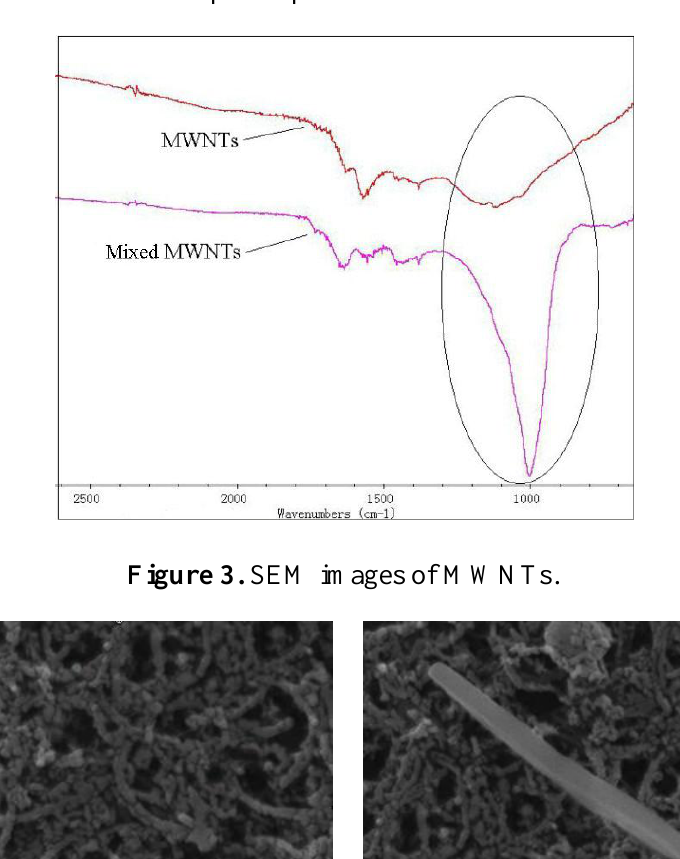
Figure 2. Infrared absorption spectra of MWNTs and mixed MWNTs.